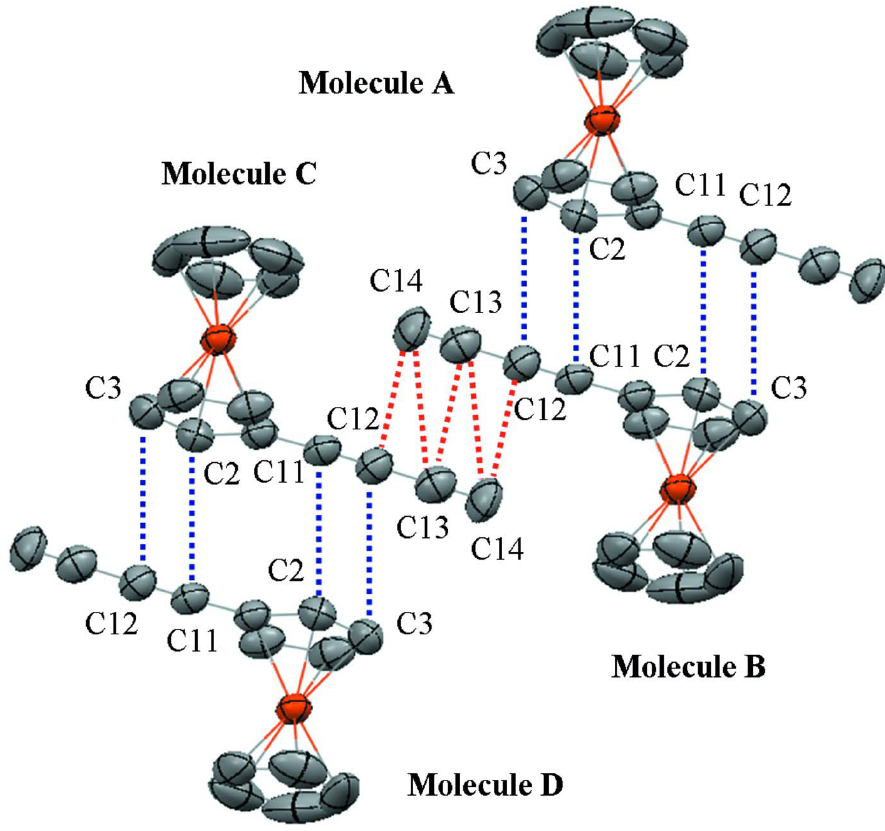
Figure 2 Intermolecular π - π interactions in the title compound. displacement ellipsoids drawn at the 50% probability level. Molecules located at: 1 - x, 3/2 + y, 3/2 - z (molecule A); 1 + x, 3/2 - y, 1/2 + z (molecule B); 1 - x, 1/2 + y, 3/2 - z (molecule C); and 1 + x, 1/2 - y, 1/2 + z (molecule